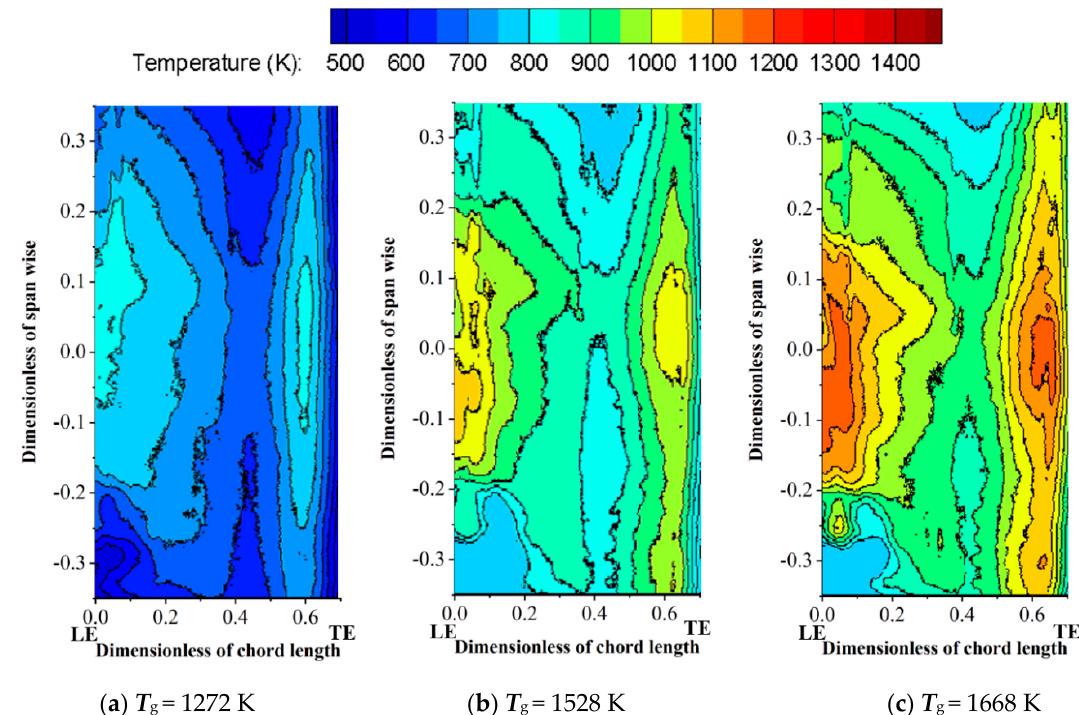
Figure 16. Temperature fields of the blade pressure surface at gas temperatures of 1272, 1528 and 1668 K before the sand particle seeding system was commenced.